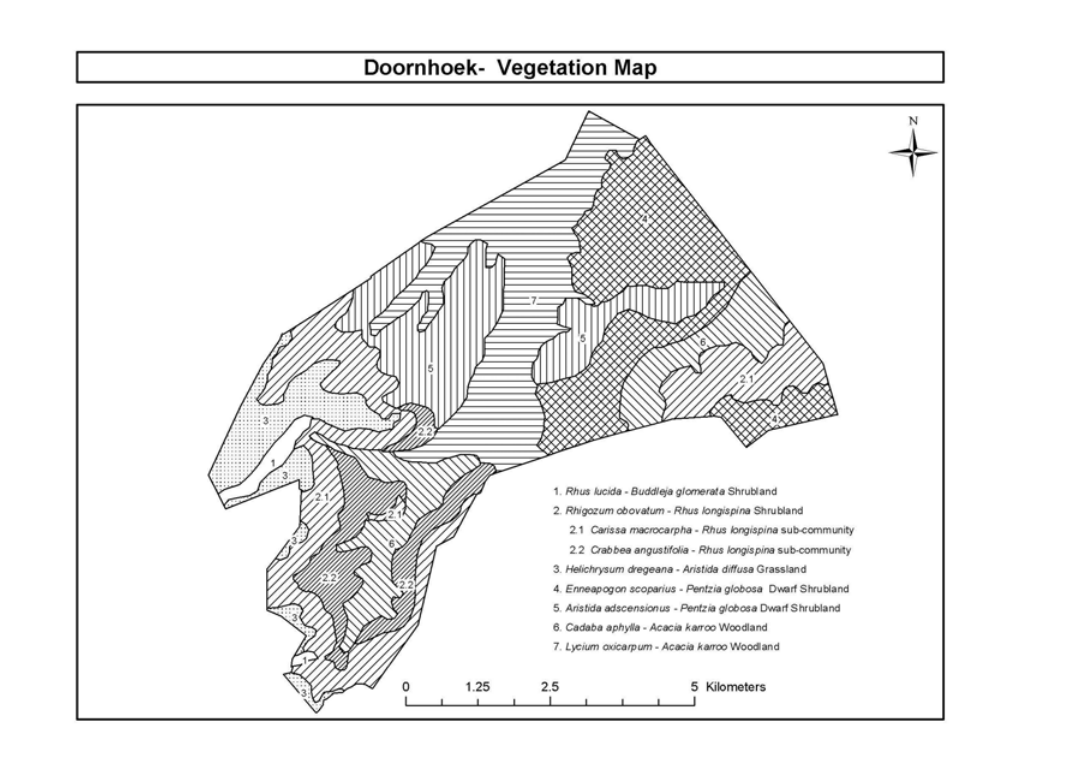
Figure 3 Vegetation map for the Doornhoek section of the Mountain Zebra National Park